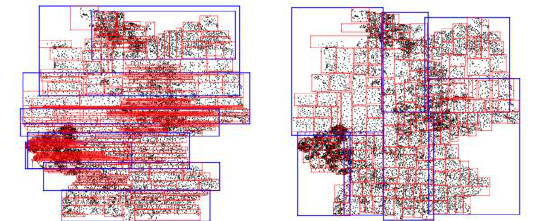
Figure 5: Examples of visualized indices of different splitting heuristics; left: R-tree quadratic split; right: R*-tree topological split (Wikipedia, 2012).